Question: In one sentence, what is this figure communicating?
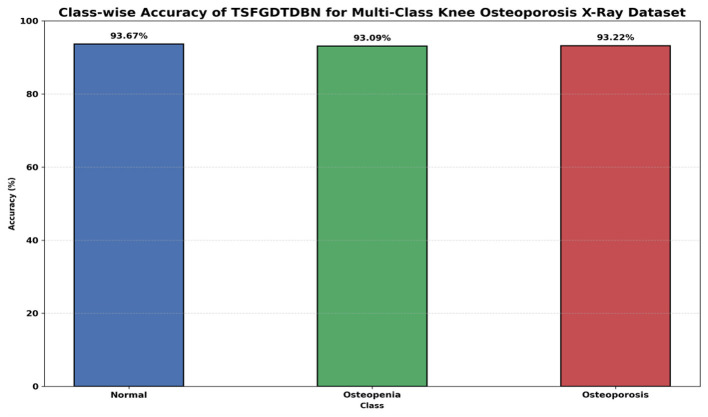
Answer: Class-wise accuracy performance for TSFGDTDBN using Multi-Class Knee Osteoporosis X-ray Dataset.